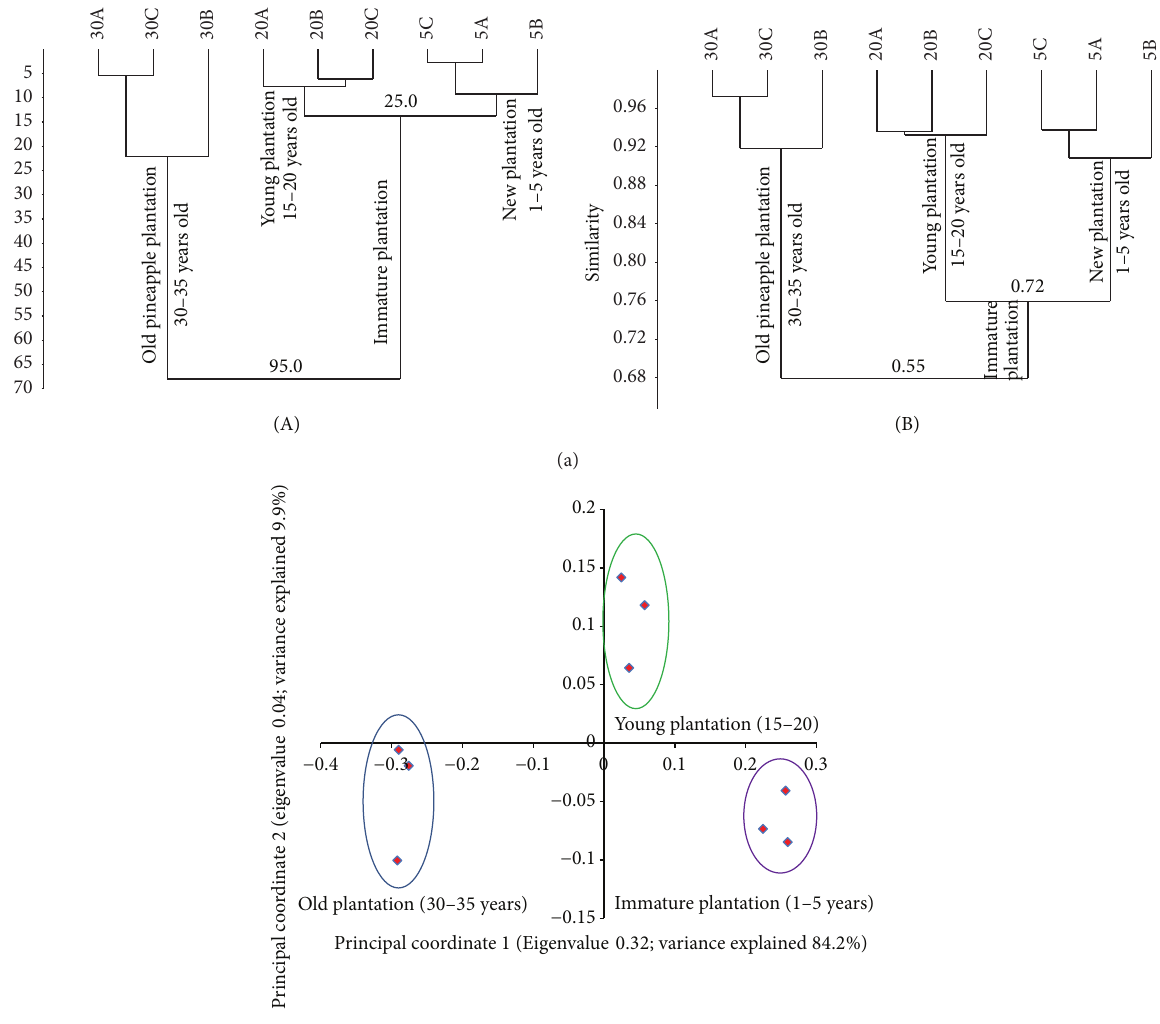
Figure 8: (a) Clustering of sampling plots: (A) according to soil properties (Euclidean distances); (B) according to characteristics of earthworm assemblages and species composition (Bray-Curtis index). (b) Principal coordinates analysis of pineapple plantation sampling plots. First and second principal coordinates explain 81.9% and 11.9% of total variance, respectively.